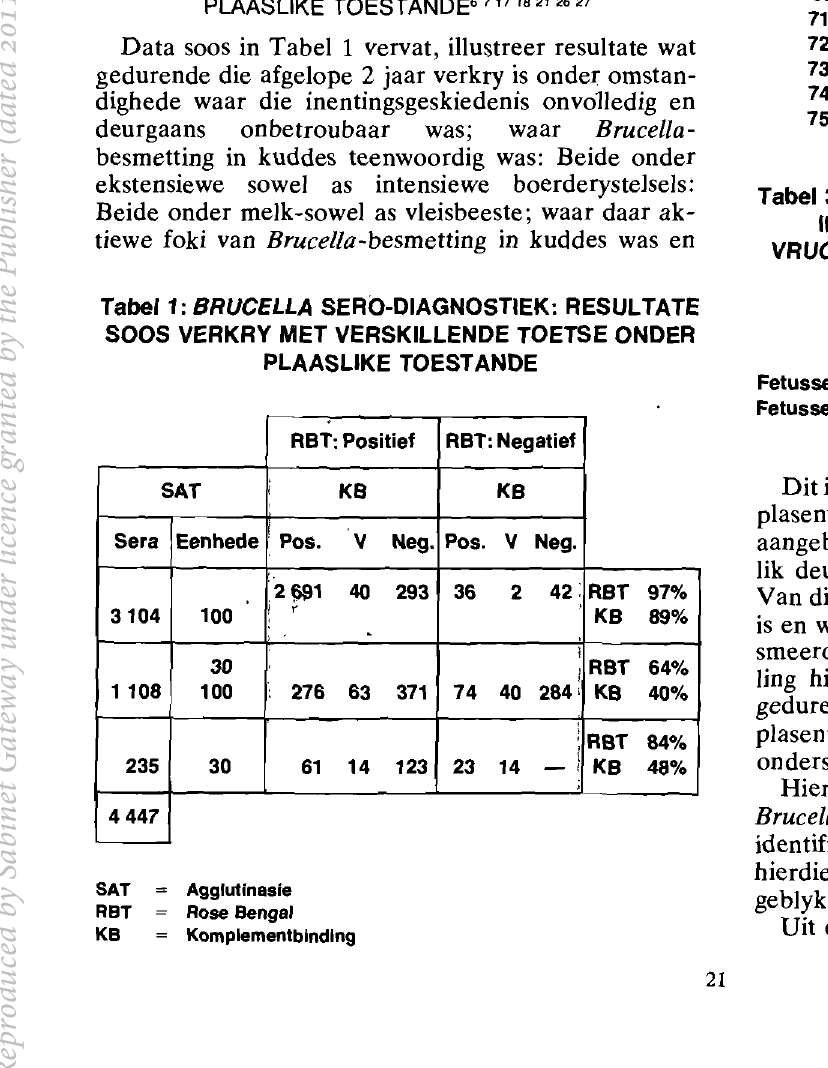
Tabel2: ONDERSOEKE NA DIE VOORKOMS VAN B.